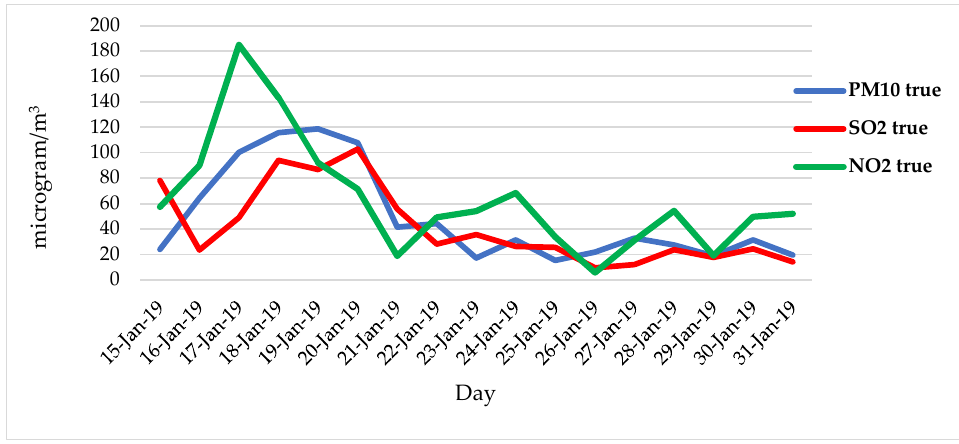
Figure 7. Measured values of the three air pollutants to be predicted.